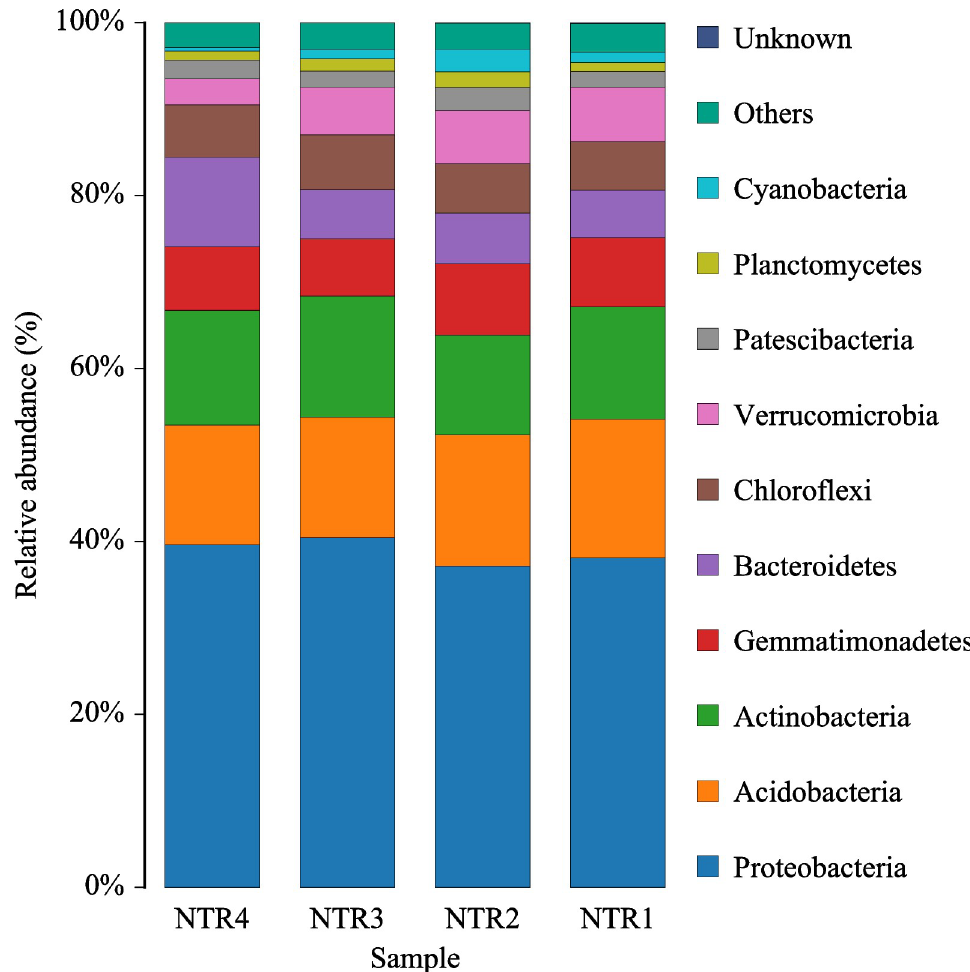
Fig 3. Relative abundance of top 10 soil bacterial phyla for all samples after different no tillage and crop residue mulching treatments. NTR1, no tillage and all crop residue removed; NTR2, no tillage and 30% crop residue mulching; NTR3, no tillage and 60% crop residue mulching; NTR4, no tillage and all crop residue mulching. The stacked bar graph represents relative abundance of the major